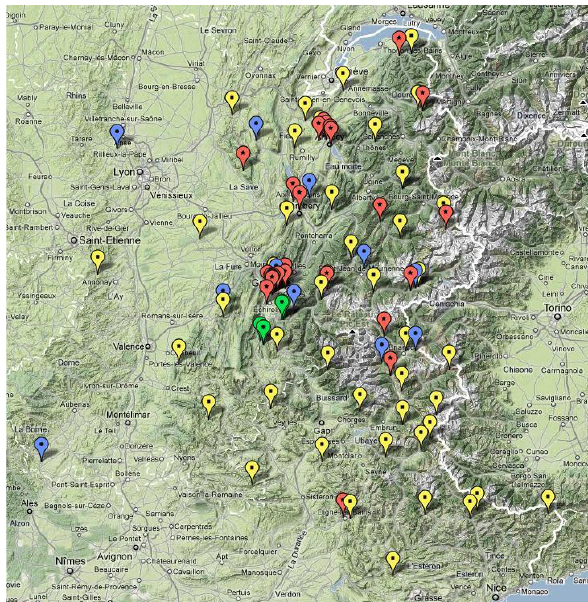
Fig. 1. Geographical distribution of the 99 permanent sites that are operated by ISTerre accross the French northern Alps. 33 Strong-Motion (SM) stations from the French Accelerometric Network (RAP) – (red); 37 Short-Period (SP)+7 Broad-Band (BB) stations from the RLBP/Sismalp network – (yellow); 16 GPS from the French Geodedic Network (RENAG) – (blue); 6 Mid-Band stations from the French landslides network (OMIV) – (green)